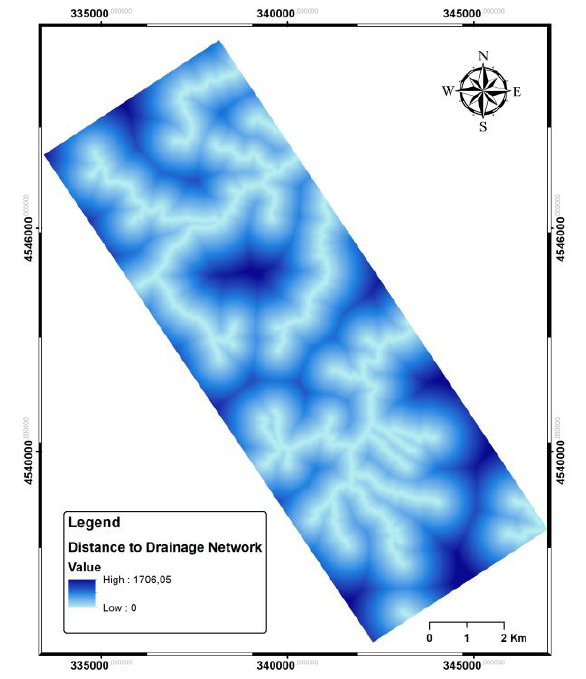
Figure 10. Distance to drainage network map of the study area.